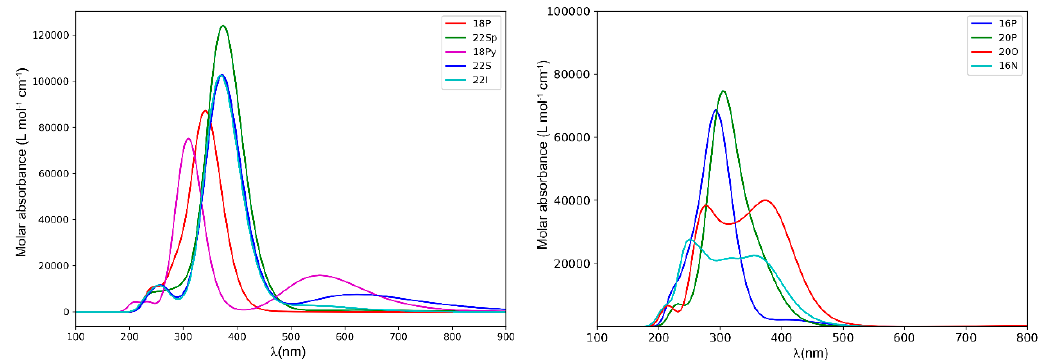
Figure 9. Absorption spectra of unsubstituted aromatic ( left ) and antiaromatic ( right ) Hückel porphyrinoids simulated using Gaussian functions with a halfwidth of 2686 cm − 1 .